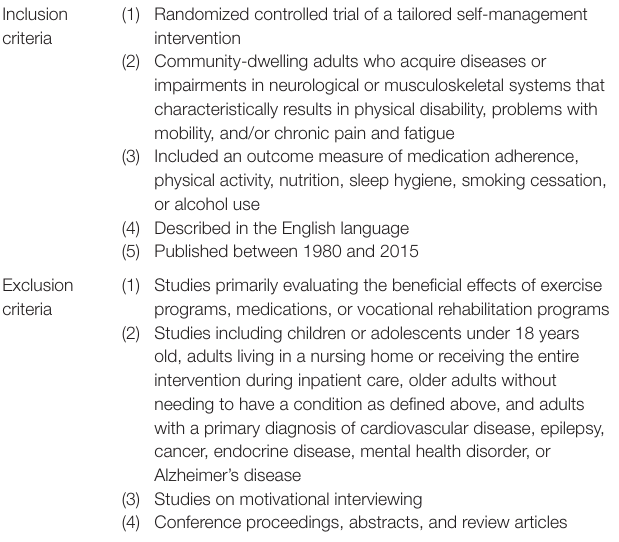
TABLe 1 | Study criteria. Inclusion